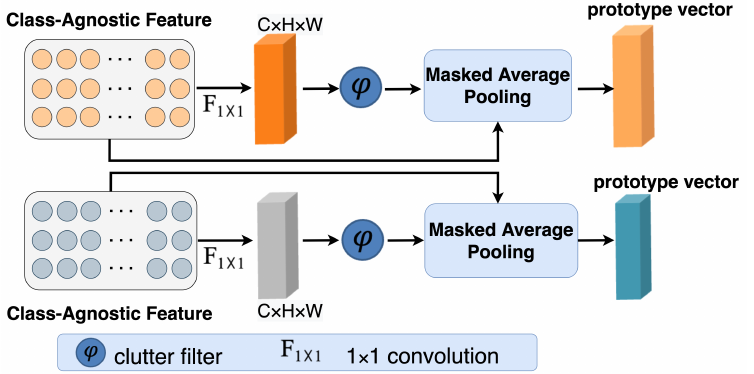
Figure 2. The schematic diagram of prototype vector